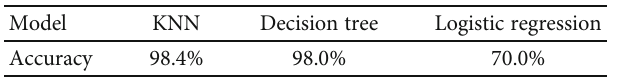
Table 1: Classi fi cation score of applied models. Table 2: Sensitivity and speci fi city of the classi fi